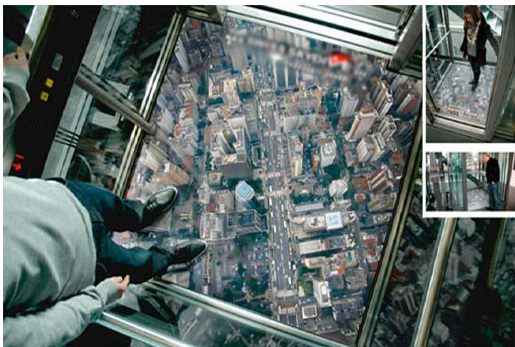
Figure 4. The on-wall advertising applied to an elevator of a high-rise building conducted by a parascending school operating in Europe